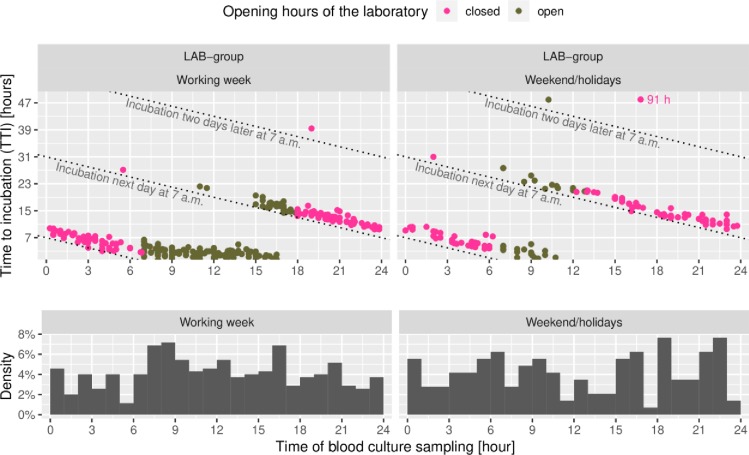
Time to incubation related to time of blood culture sampling (LAB group).Top: Magenta dots represent sampling during laboratory off-hours, green dots during working hours. Bottom: Overall distribution of sampling during working week and on weekends/holidays.